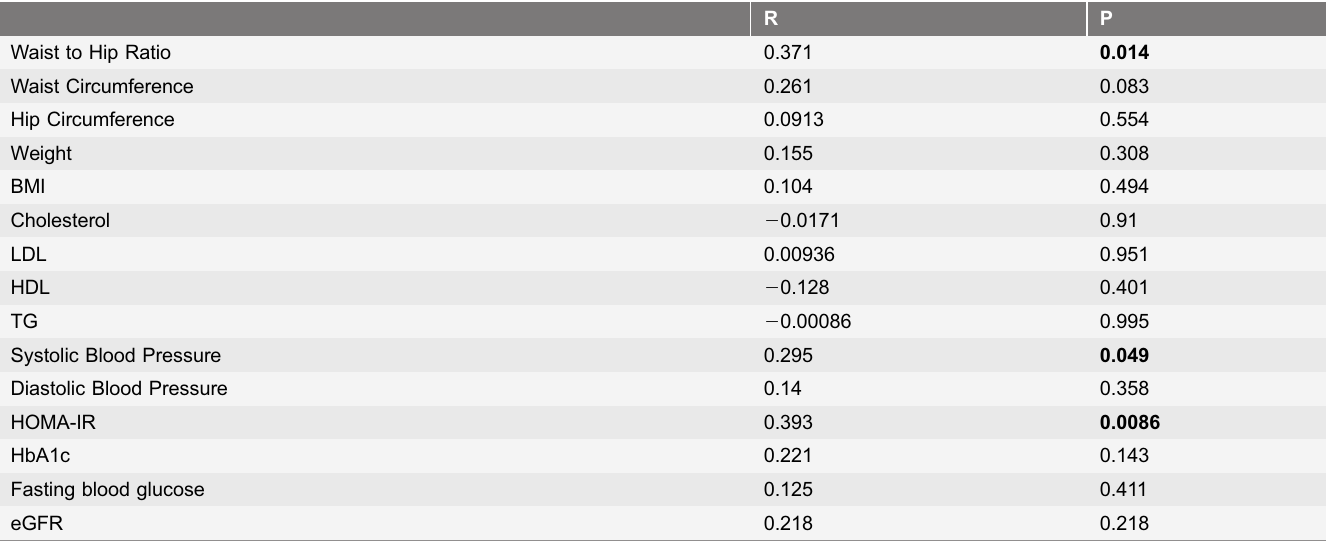
Table 2. Univariate Spearman correlations between U-LTE 4 and clinical/biological parameters ( n 5 46). R P Waist to Hip Ratio 0.371